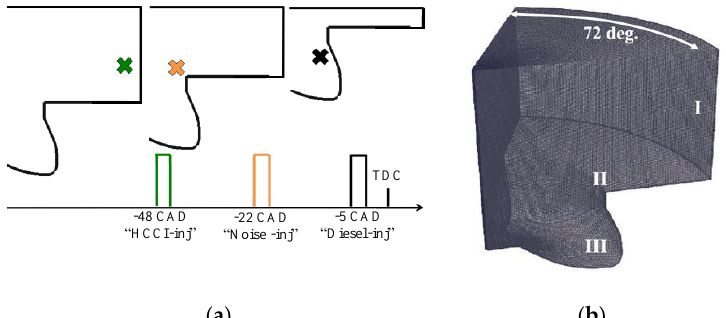
Figure 1. The triple injection strategy and the target points for case 1 and the experimental work ( a ) and the simulated sector mesh geometry ( b ). The spray target points are marked using the cross symbol in the left subfigure, whereas they are labeled as I–III in the right subfigure. Details about the engine configuration and piston geometry can be found in Borgqvist et al. [12,13,20].